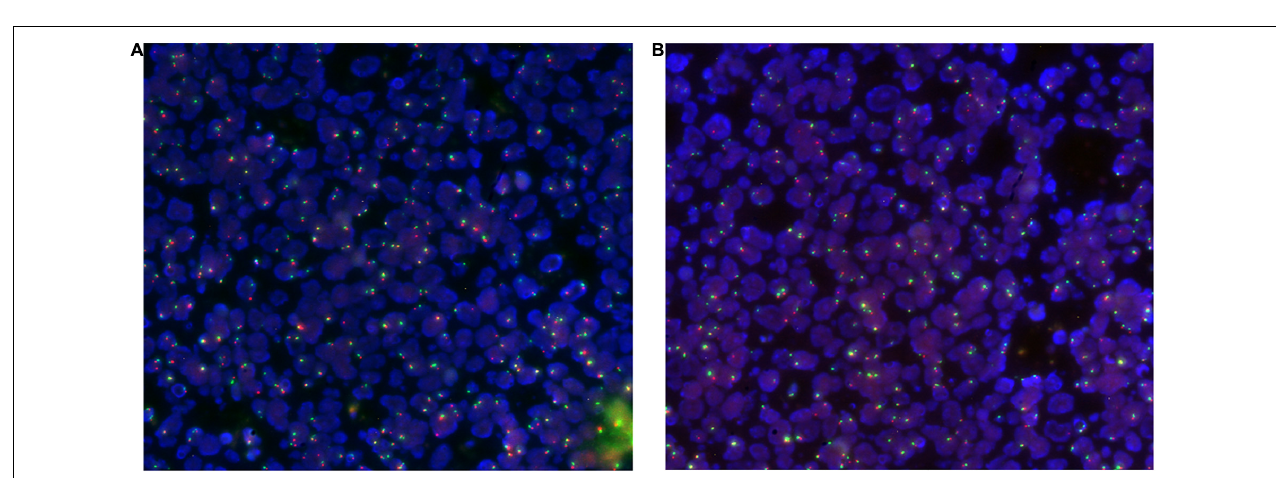
FIGURE 5 | Duodenal mucosa, Ki 67 image and drawing of the image analysis. Cell nuclei were counted using the following parameters range as listed in the following: size (inches 2 ) 20-infinity; circularity (0.10–1.00).